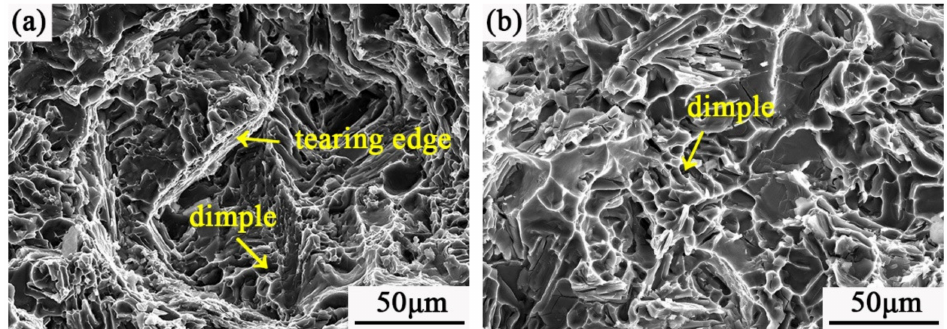
Figure 4. Fracture morphology of the Al-7Si-0.55Mg alloy: ( a ) As-cast and ( b ) with conventional heat